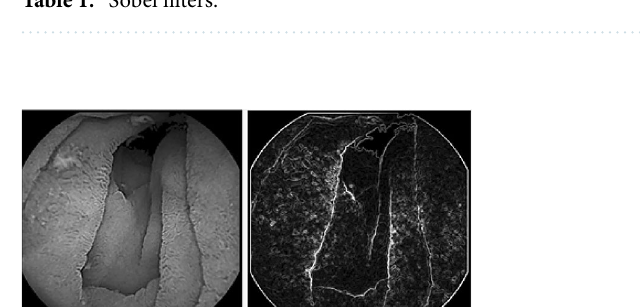
Table 1. Sobel filters.